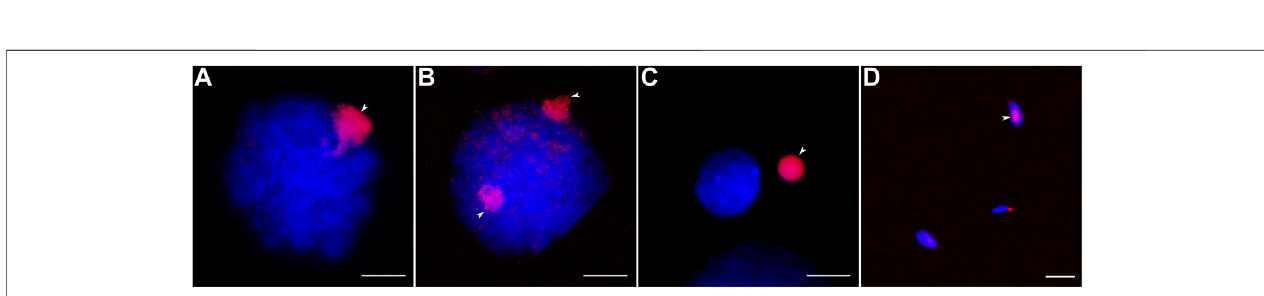
FIGURE 2 | Male germ cells after H3K9me3 labeling (red) and DAPI staining (blue). (A, B) Cells with one (A) and two (B) GRC copies. (C) Post-meiotic cell and eliminated GRC. (D) Spermatozoa with and without GRC. Arrowheads point to GRCs. Bar — 10 µm.